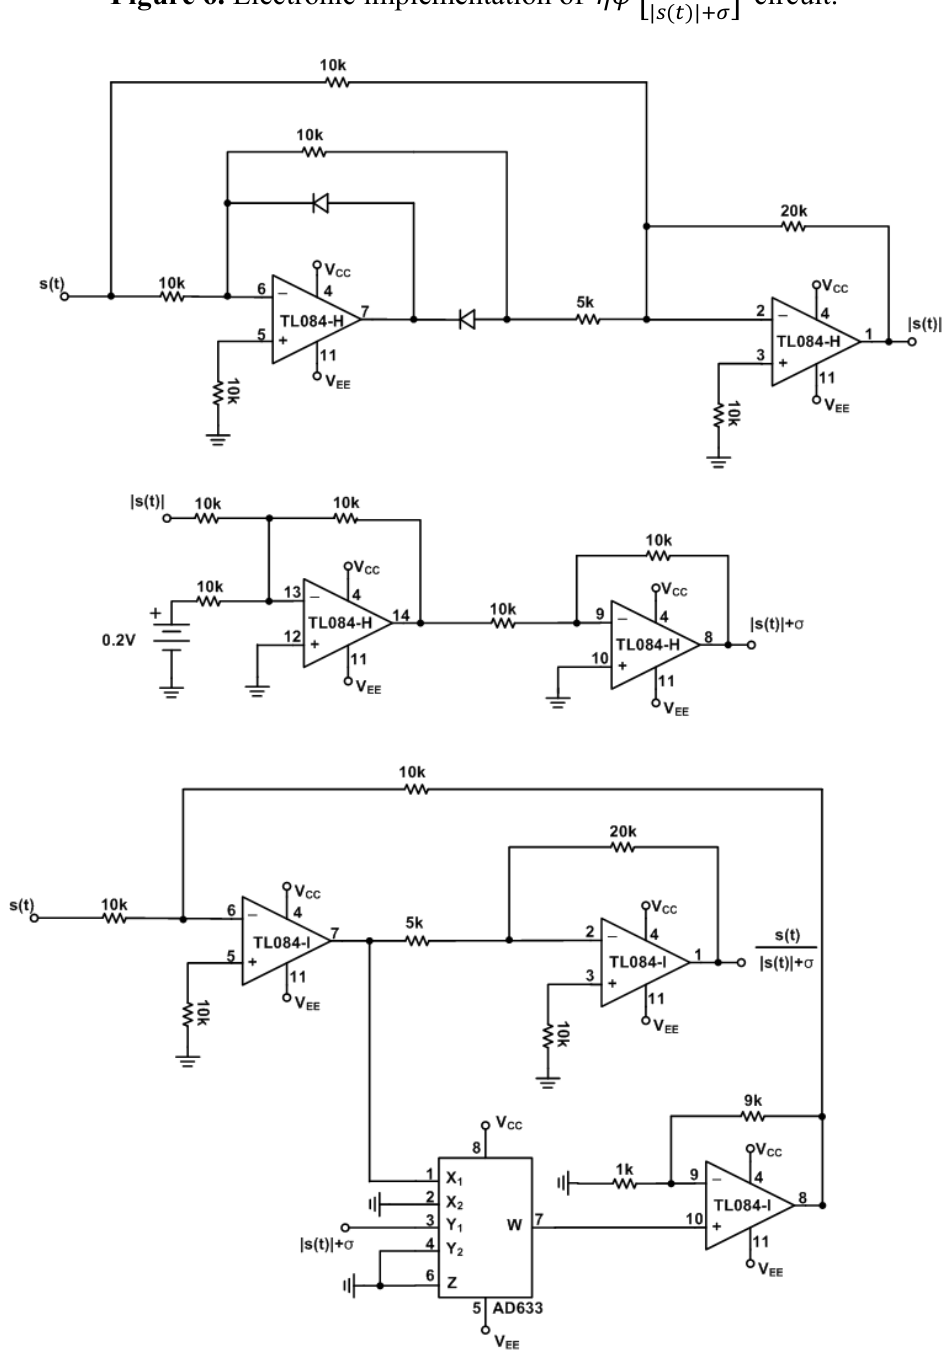
Figure 6. Electronic implementation of (cid:2015)(cid:2032) (cid:4674)